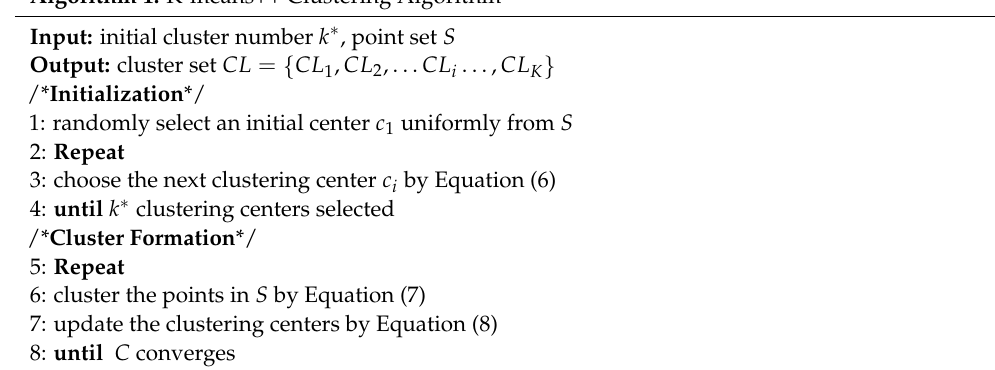
Algorithm 1. K-means++ Clustering